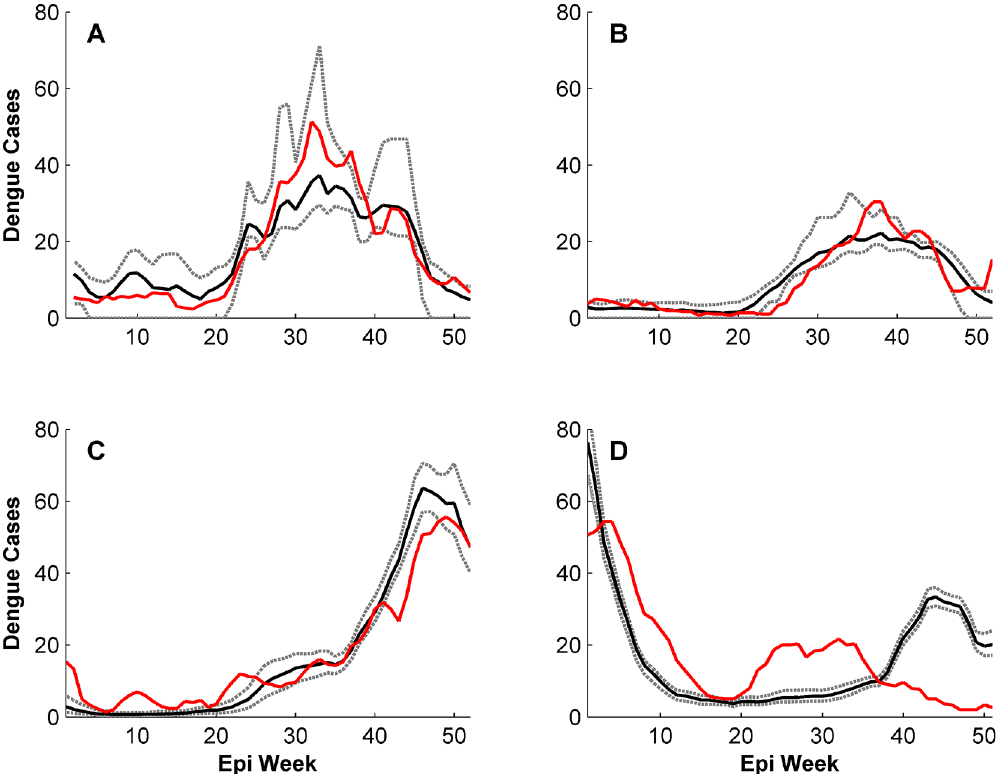
Fig 3. Simulated and reported weekly total dengue fever cases with model parameterized for individual years. The red line is reported DF cases, the black line is the ensemble mean of simulated DF cases, and the dashed gray lines are the ensemble maximum and minimum. Intra-annual variability is captured exceptionally well when the model is parameterized for the individual years 2010(A), 2011(B), and 2012(C). 2013(D) is not simulated as